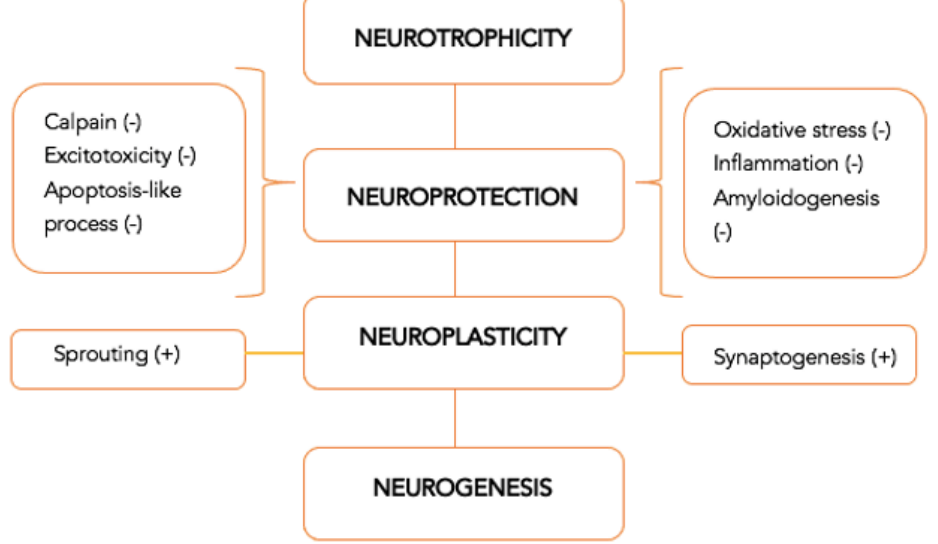
Figure 2. Multimodal drugs with pleiotropic neuroprotective effect—mechanism of action [5].